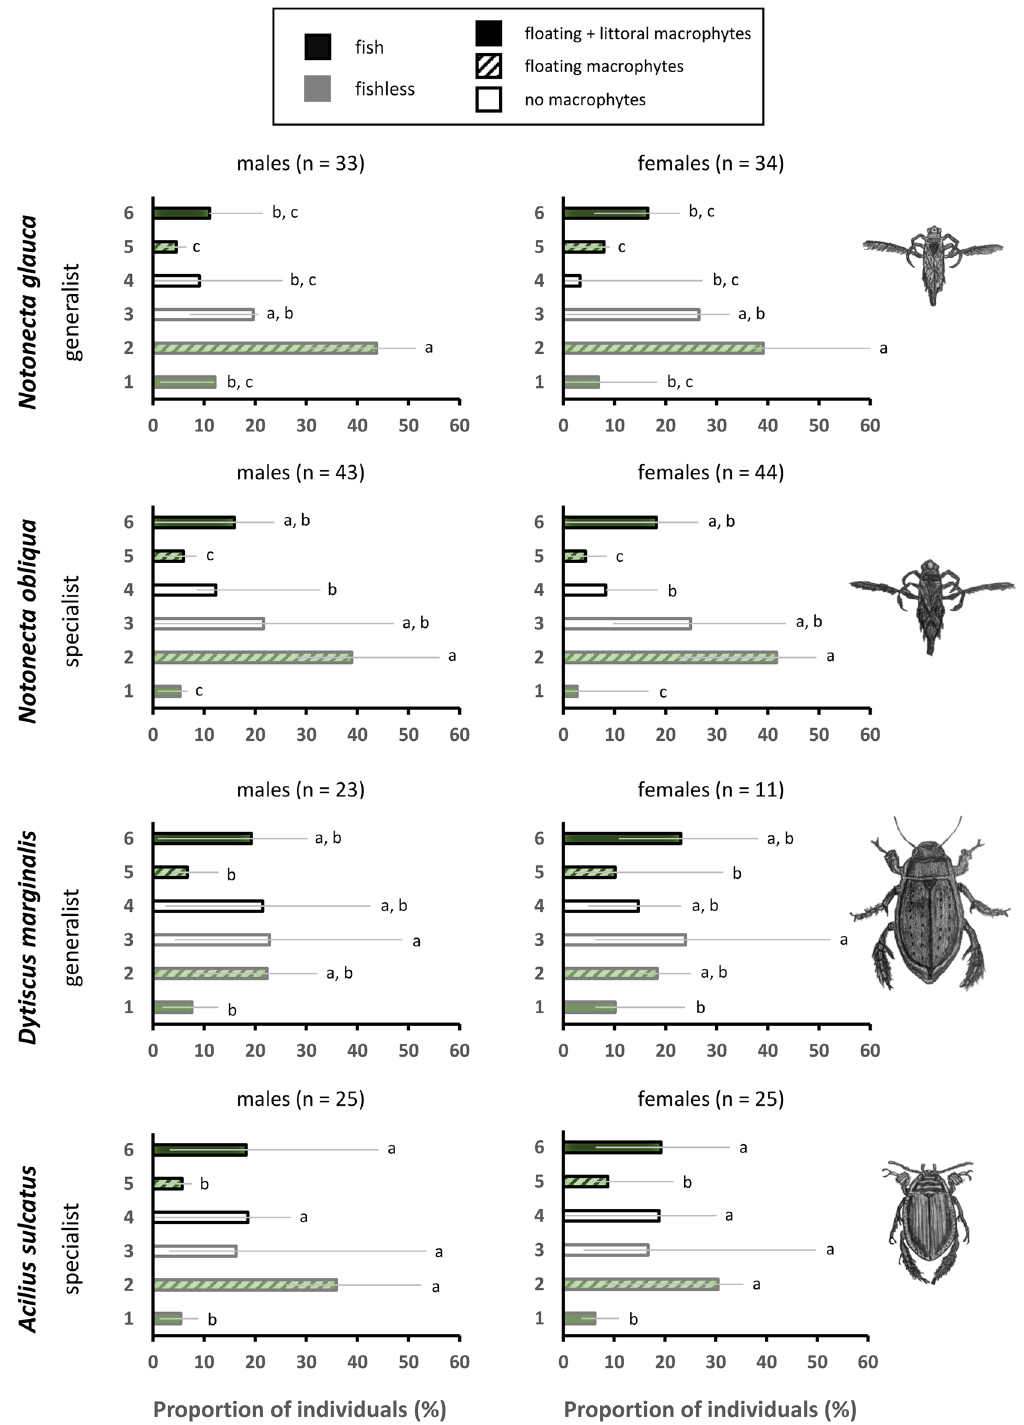
Figure 1. Overall habitat preferences of the study taxa. Proportion of occurrences in six habitat types (fish and fishless pools without macrophytes, with submersed and floating macrophytes, or with submersed, floating plus littoral macrophytes) in backswimmers ( Notonecta glauca , N. obliqua ) and diving beetles ( Dytiscus marginalis , Acilius sulcatus ). Notonecta glauca and D. marginalis represent habitat generalists, while N. obliqua and A. sulcatus are species specialised for life in fishless habitats, as they are vulnerable to fish predation. Error bars show the variance in preferences of individuals for each habitat type among individual blocks; n is the number of individuals entering the